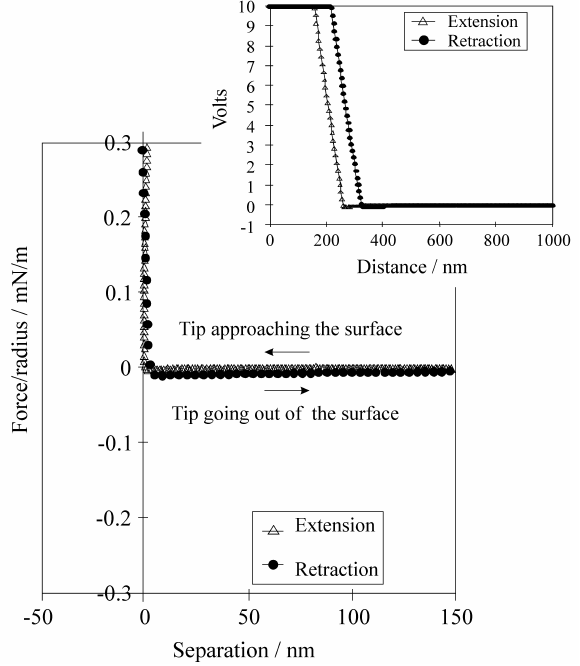
Figure 7. Force-distance curve for a glass sphere attached to an AFM cantilever against a silica surface in water. Raw data shown on the top.